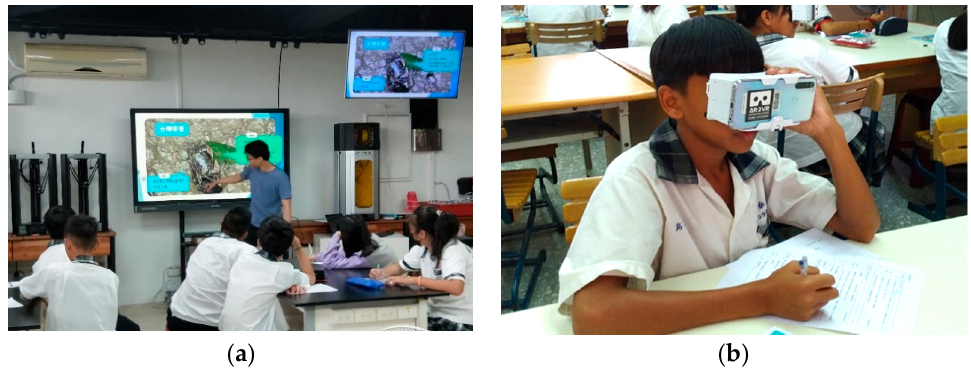
Figure 12. Learning activities of ( a ) the control group and ( b ) the experimental group.